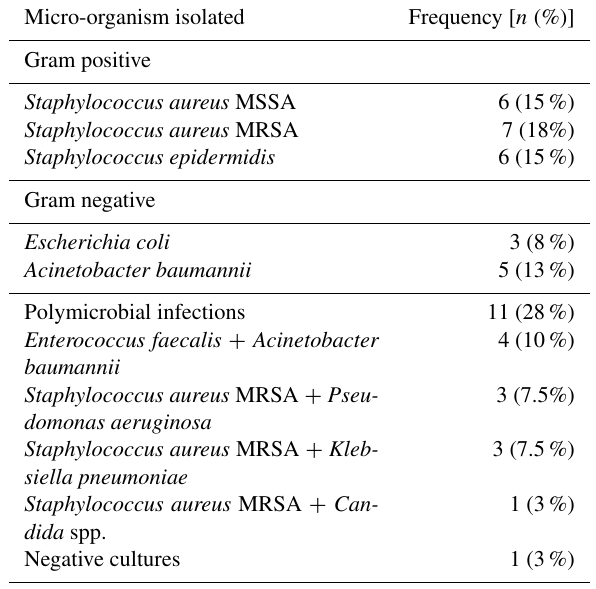
Table 2. Micro-organisms isolated from infected hip fracture cases. Micro-organism